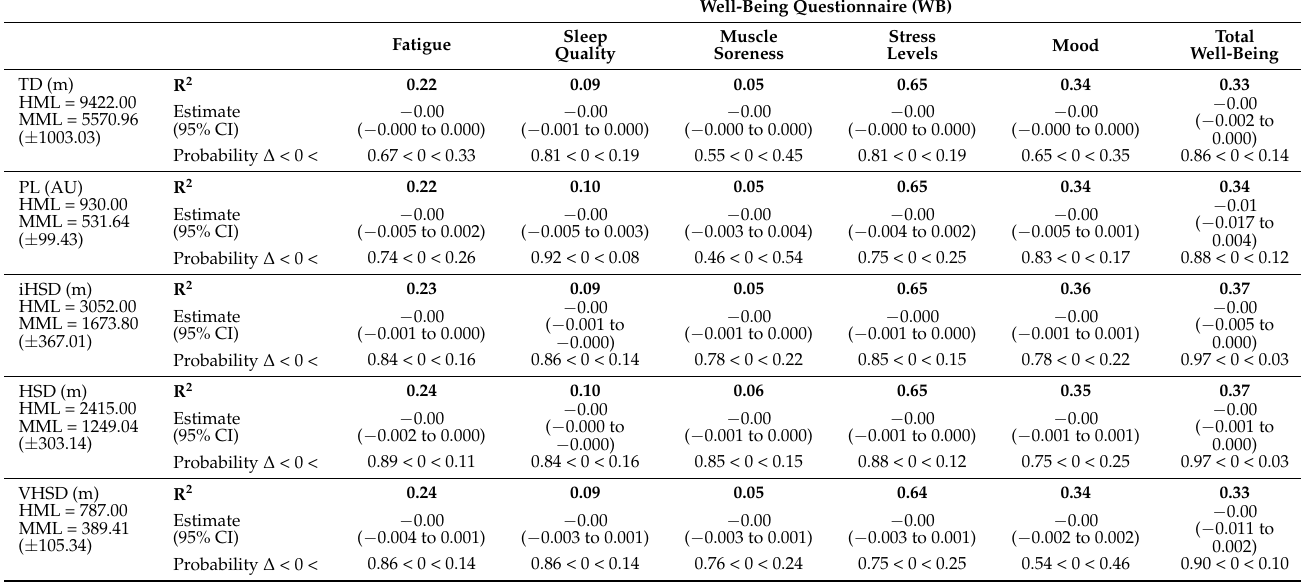
Table 3. Bayesian linear mixed model analysis of the relationship between external load measures (independent variable) and next-day well-being questionnaire (WB) ( n =